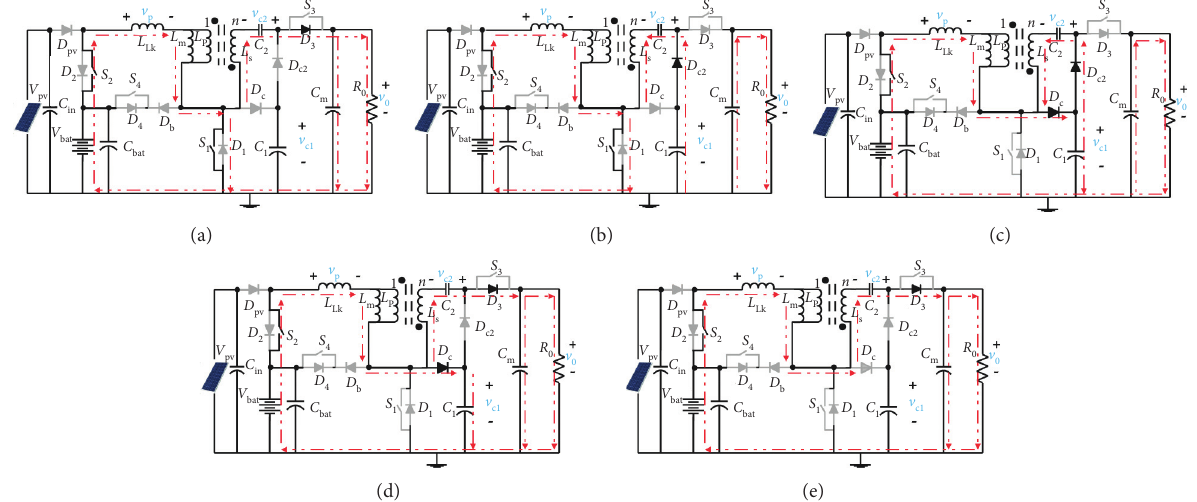
Figure 3: Steady-state equivalent circuits and current flow of the converter in SISO mode (boost operation). (a) t (c) t ∼ t . (d) t ∼ t . (e) t ∼ t . 2 3 3 4 4 5